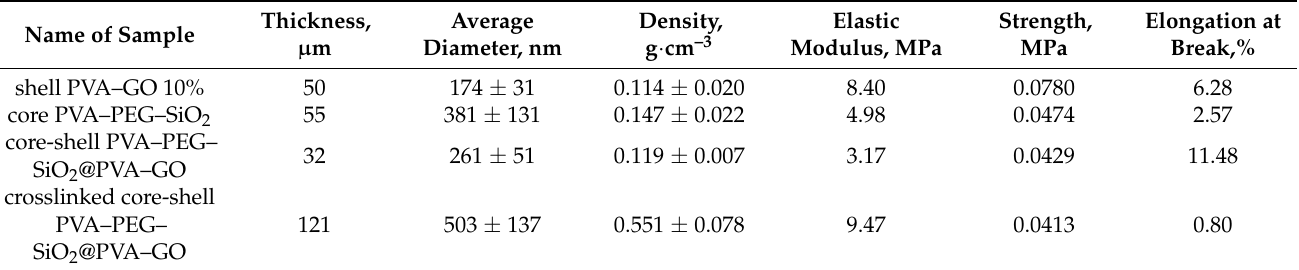
Table 4. The tensile properties of PVA–PEG–SiO 2 @PVA–GO, PVA–PEG–SiO 2 (core), and PVA–GO (shell)